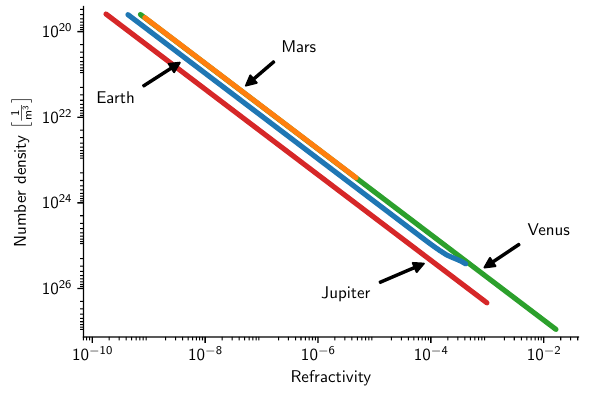
Figure 3. Refractivity profiles for different planets. Density is used here for the vertical scale instead of pressure because otherwise the figure is complicated by the widely different temperatures on dif- ferent planets leading to different densities at similar pressures. The model atmospheres here are the same as in Fig. 1 and described in the caption of Table 2. Data begin at the planets’ surface, except for Jupiter, where they begin at the lowest level of our model atmo-